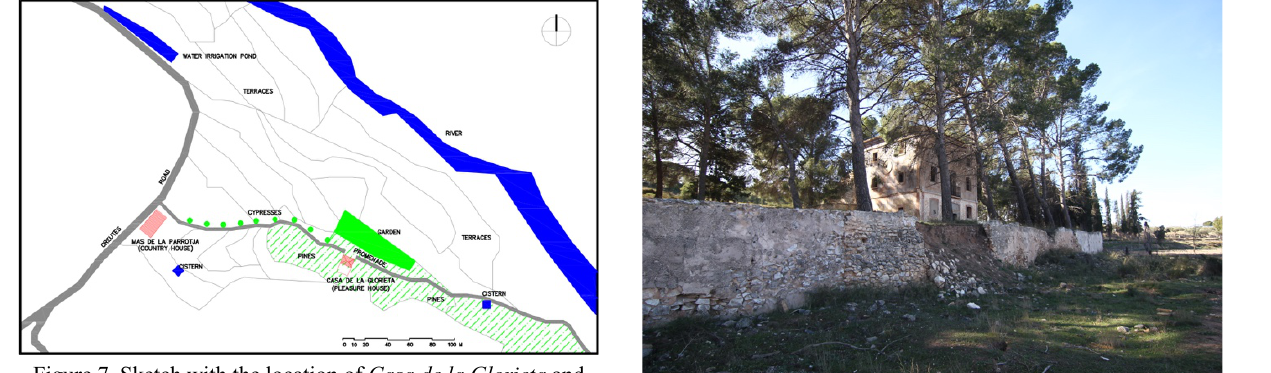
Figure 7. Sketch with the location of Casa de la Glorieta and Mas de la Parrotja.